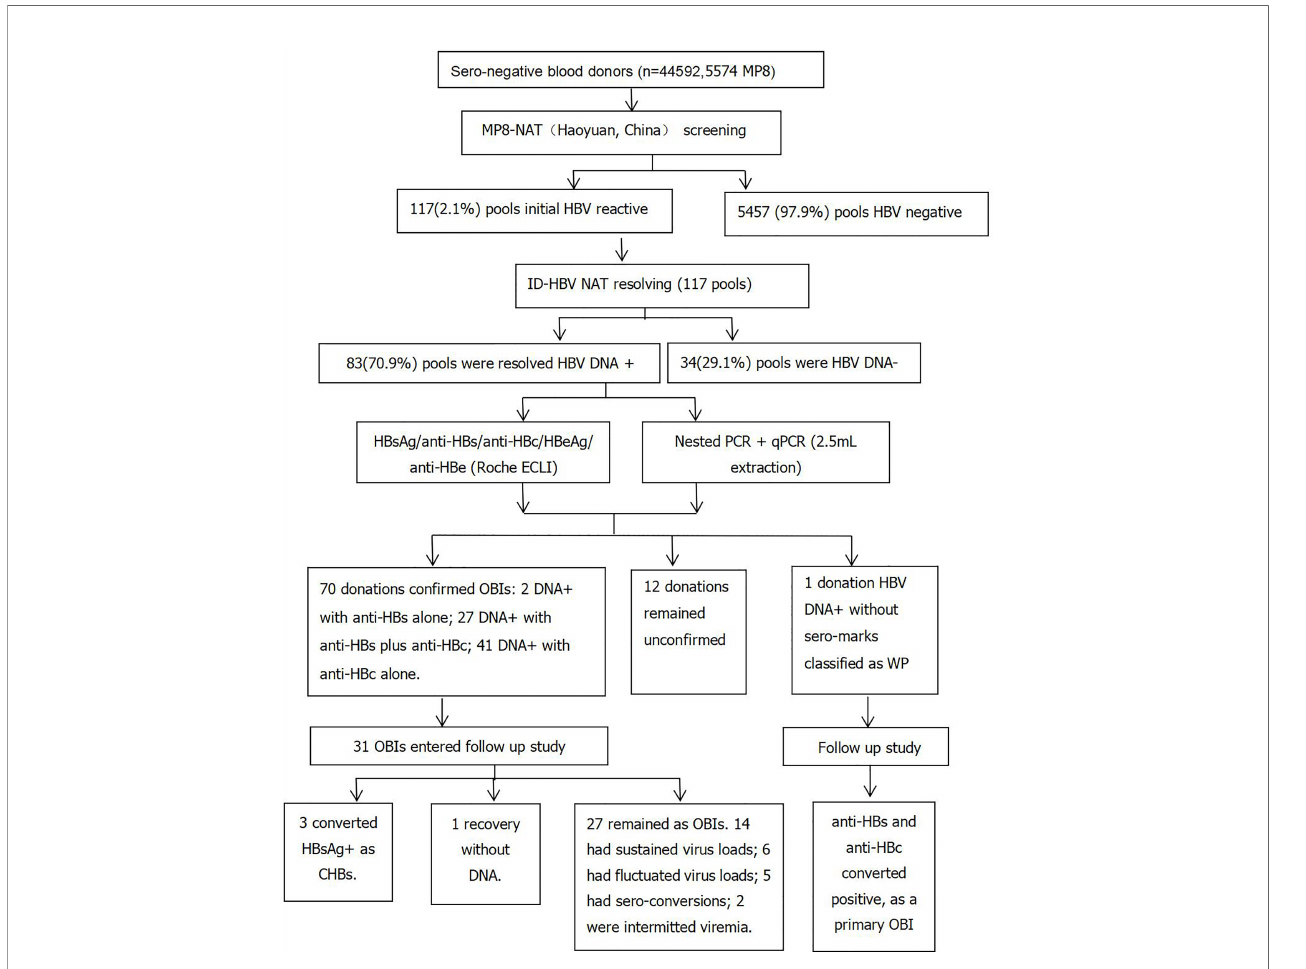
FIGURE 1 | Flowchart of the study